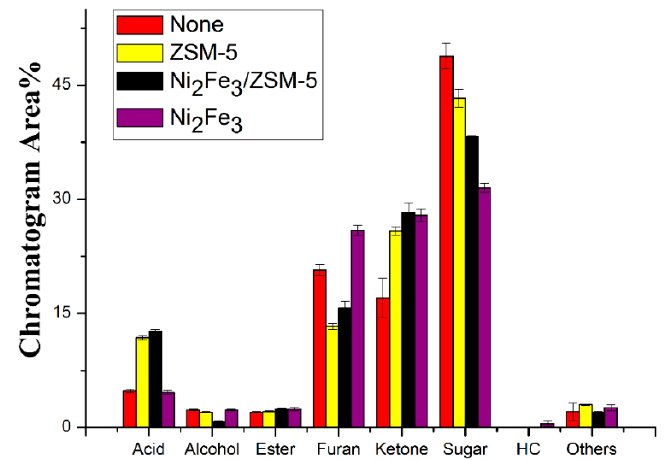
Figure 4. Chemical relative compositions of the organic phase of bio-oil without / with the ZSM-5, Ni 2 Fe 3 / ZSM-5, and Ni 2 Fe 3 catalysts (homogeneous catalysis) and None: without catalysts.